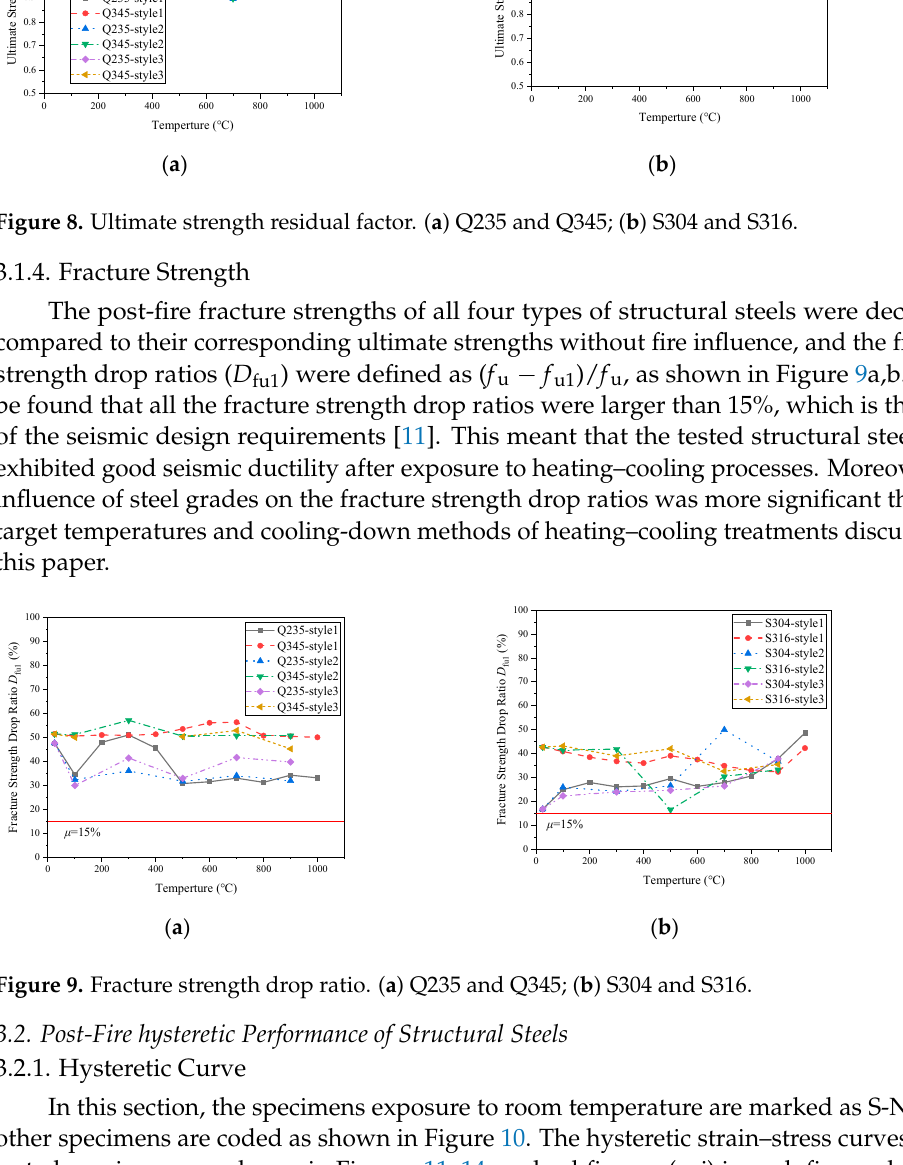
Figure 10. Specimen code.